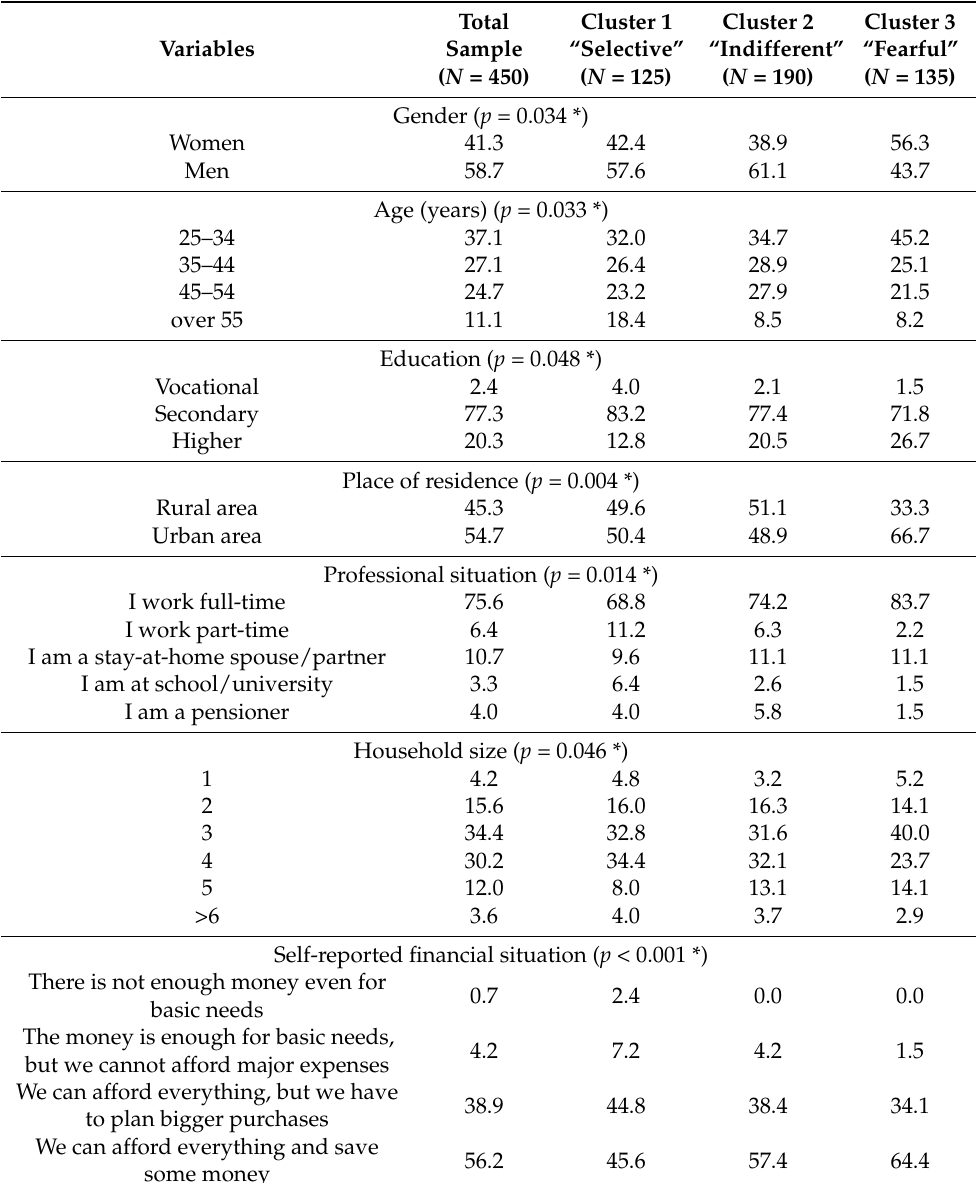
Table 1. Sociodemographic characteristics of the study sample and the identified clusters (%; N = 450,